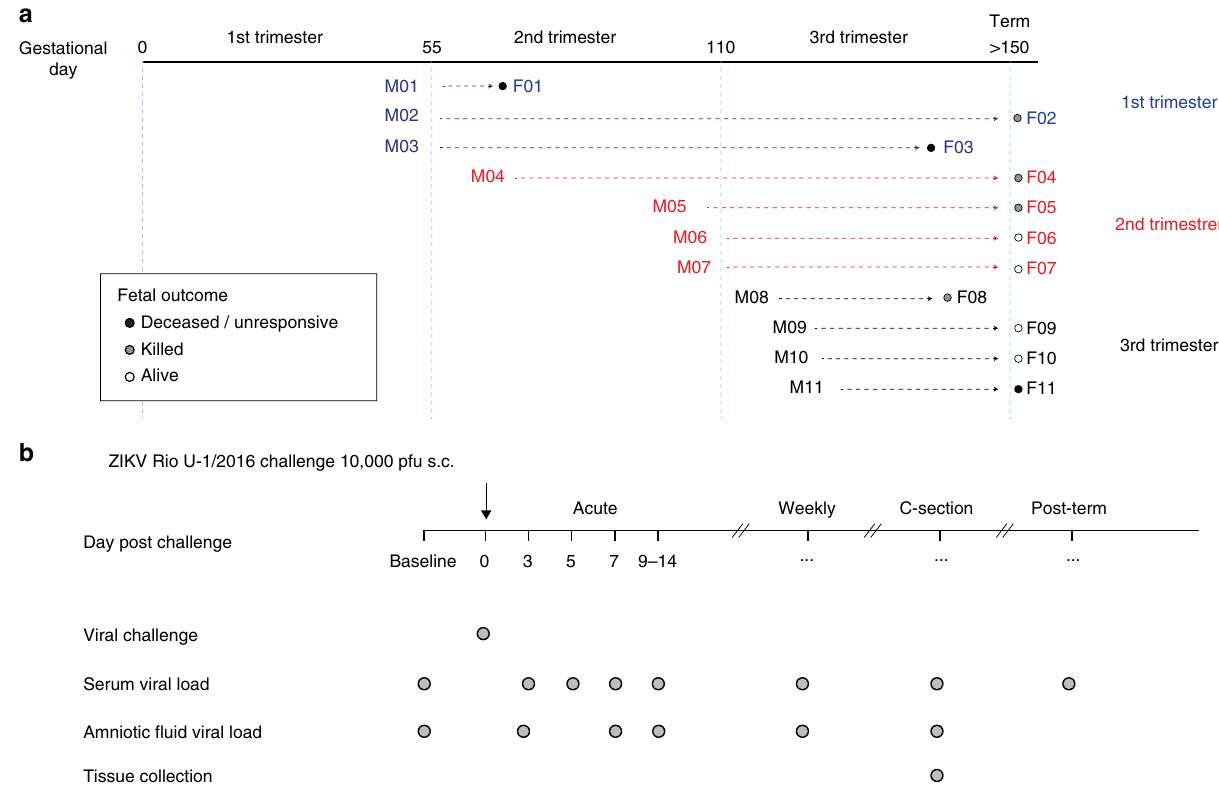
Fig. 1 Pregnant NHP study design. a We challenged 11 rhesus macaques with 10,000 pfu of ZIKV Rio U-1/2016 during the fi rst (blue), second (red), and third (black) trimester (55 days each) of pregnancy. Fetal outcomes; deceased/unresponsive, killed, or alive are indicated by black, gray, and white, circles, respectively. b Dam and fetal samples were collected at the indicated time